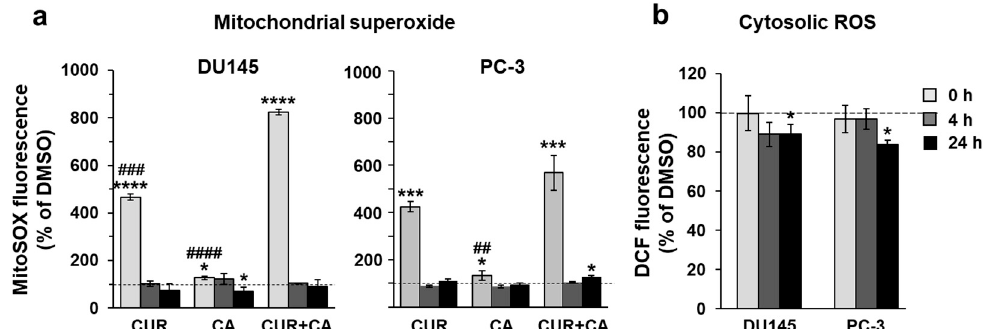
Figure 8. Effects of polyphenols on cellular production of reactive oxygen species. ( a ) Transient mitochondrial superoxide generation, as detected using the MitoSox probe following treatment with 7 µ M CUR and 5 µ M CA, alone and in combination (CUR + CA); ( b ) Cytosolic ROS assessed with the CM-H 2 DCFDA probe in CUR + CA-treated cells. Changes in fluorescence were recorded at 5 min (0 h), 4 h and 24 h after the addition of DMSO or polyphenols. Data are presented as mean ± SEM ( n = 3) relative to DMSO-treated cells. Statistically significant differences ( a ) for CUR, CA or CUR + CA vs. DMSO (* p < 0.05; *** p < 0.001 and **** p < 0.0001) and for CUR and CA vs. CUR + CA (## p < 0.01, ### p < 0.001 and #### p < 0.0001). In panel ( b ), significant differences for the indicated groups vs. DMSO: * p < 0.05.